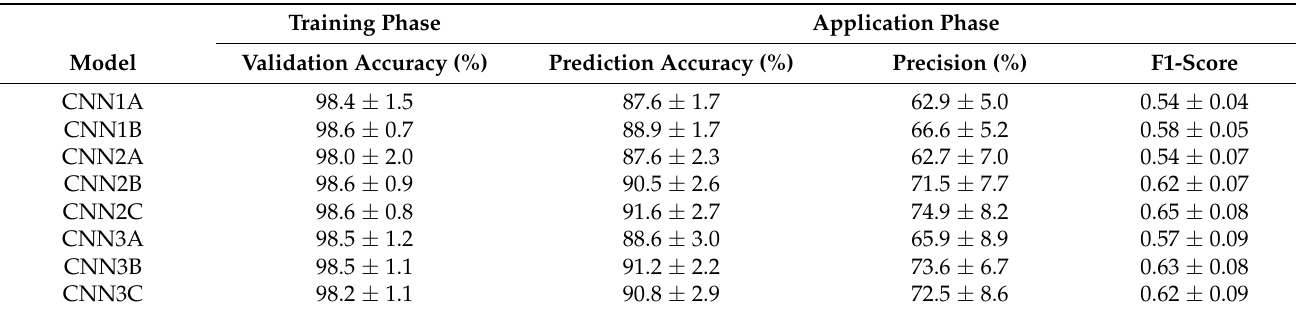
Table 4. Predictive results obtained by CNN models: mean and standard deviation of validation accuracy, prediction accuracy, precision, and F1-score from 100